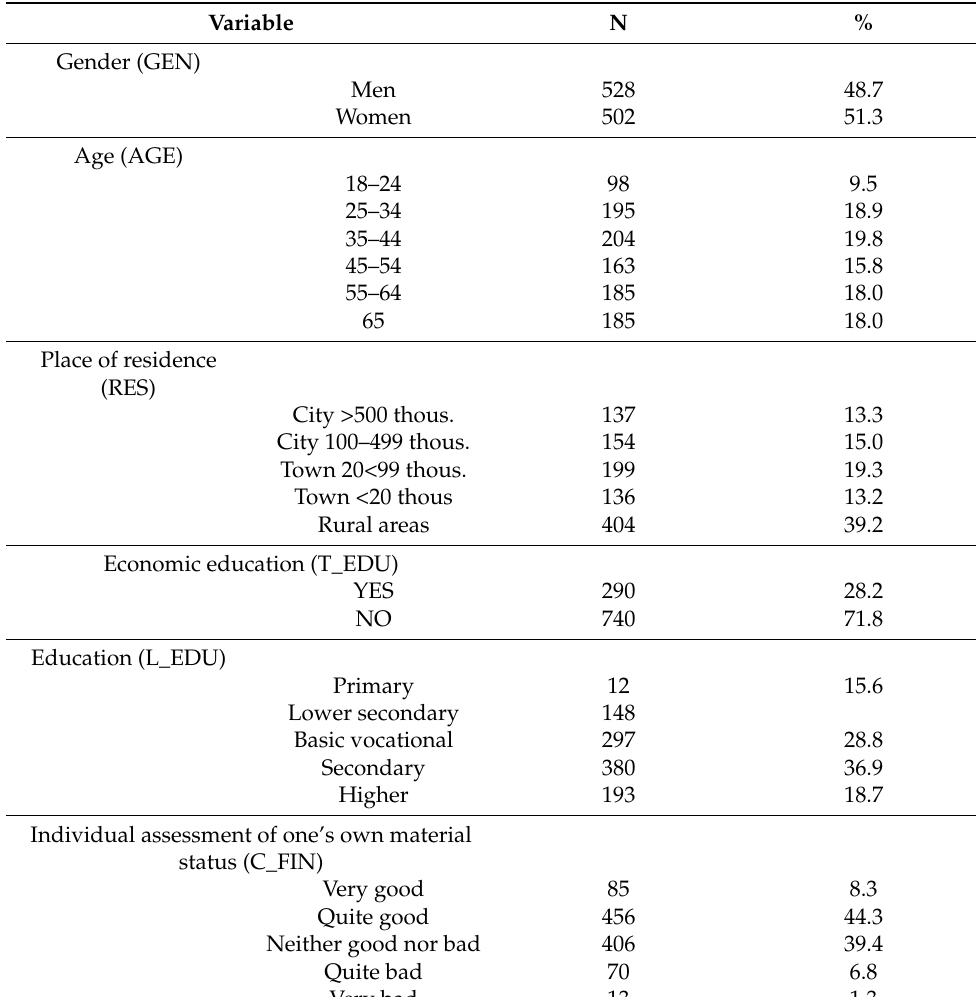
Table 1. General presentation of survey